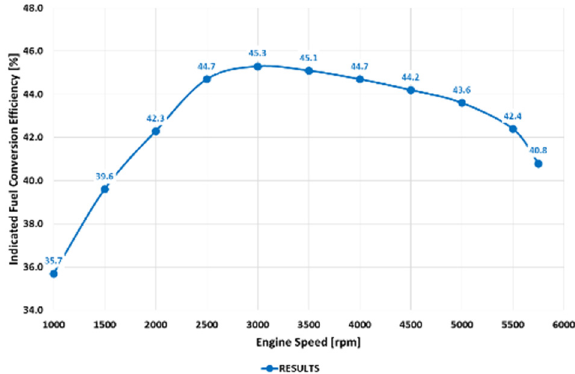
Figure 17. The engine indicated fuel conversion efficiency.